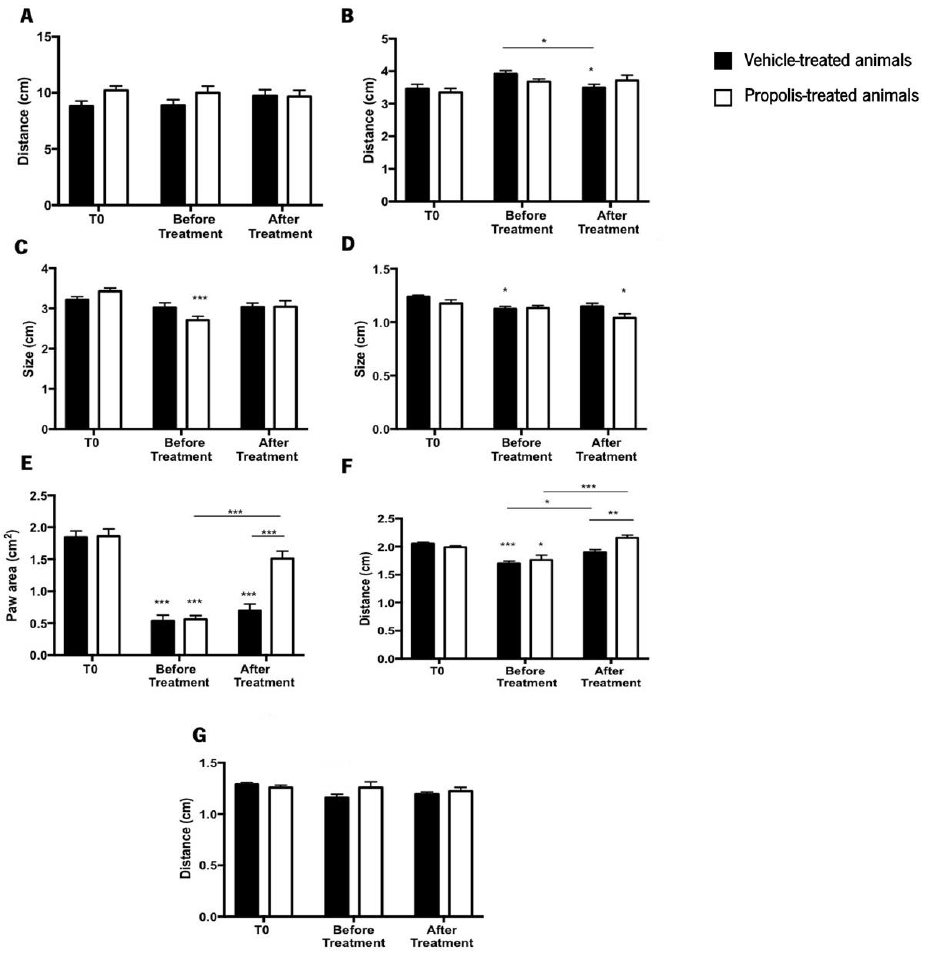
Figure 7 . Evaluation of the animal ’ s gait by the catwalk method. The parameters evaluated in this study were ( A ) stride length (SL); ( B ) lateral distance between two hind paws in successive steps (LD); ( C ) box length (LP); ( D ) box width (WP); ( E ) paw area (PA); ( F ) distance between the first and the fifth hind toe (D1 – 5); and ( G ) distance between the second and the fourth hind toe (D 1 – 4). Results were expressed as mean ± SEM (*0.05 > p ≥ 0.01, **0.01 > p ≥ 0.001, *** p < 0.001; *above the bar is related to the T 0 of the same tested group) ( ◼ — vehicle-treated animals; — propolis-treated animals).